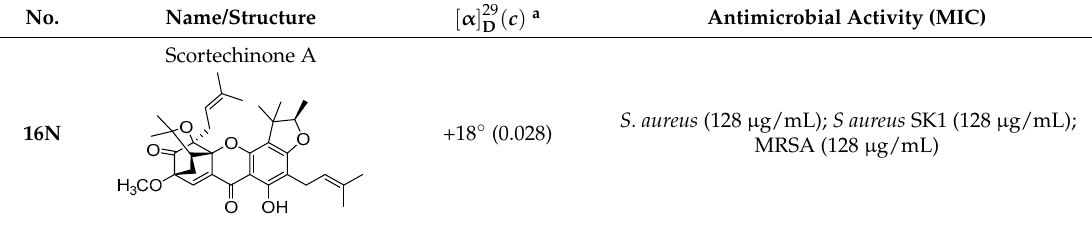
Table 4. Antimicrobial activity of natural caged xanthones: scortechinones and prenylated. No.